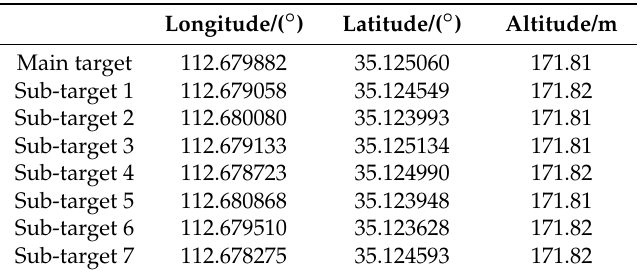
Table 3. Calculated values in the geodesic coordinates of each target.